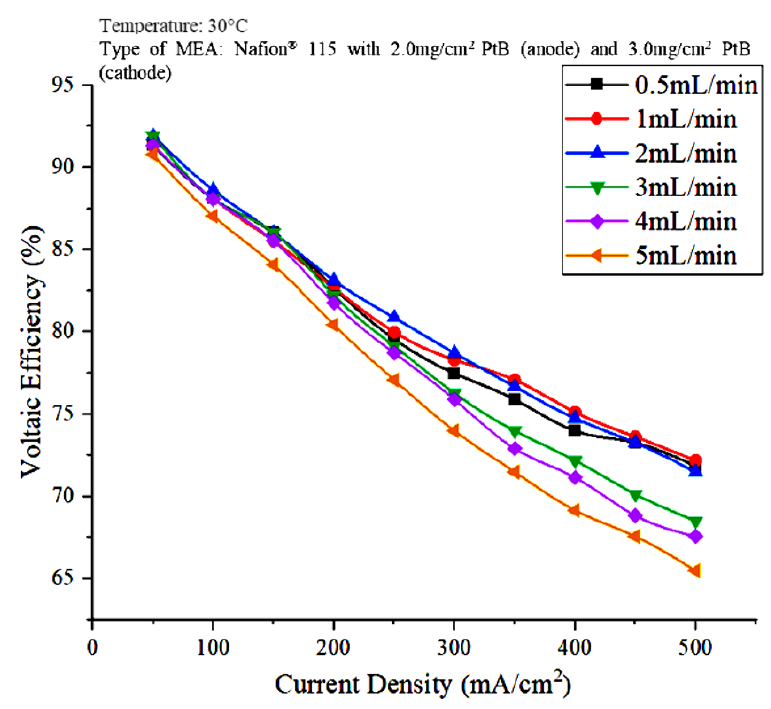
Figure 4. Effect of water flowrate on voltaic efficiency.